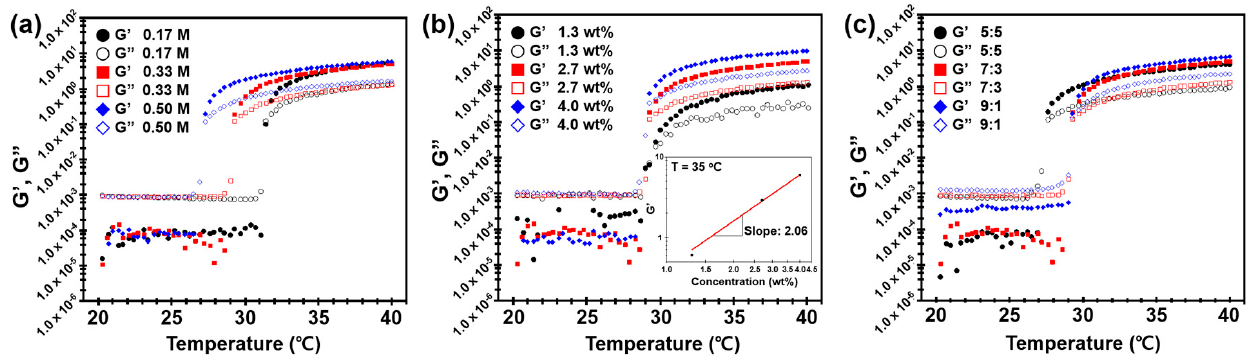
Figure 3. Evolution of storage (G’) and loss (G”) moduli of the p(NiPAm-co-HEMA) microgel dispersion from 20 °C to 40 ◦ C. The procedure was conducted under fixed stress of 0.05 Pa and a frequency of 0.1 Hz ( ω = 0.63 rad/s). ( a ) Change in dynamic modulus of the polymer at different salt concentrations. The concentration of polymer and molar ratio between NiPAm and HEMA were kept constant at 2.7 wt% and 7:3, respectively. ( b ) Change in dynamic modulus at different copolymer concentration ( c m ). The concentration of NaCl and molar ratio between NiPAm and HEMA were kept constant at 0.17 M and 7:3, respectively. Log plot between G’ and microgel concentration showed a power-law relationship with a slope of 2.06 (inset). ( c ) Change in dynamic modulus at different molar ratios between NiPAm and HEMA. The concentrations of polymer and NaCl were kept constant at 2.7 wt% and 0.33 M, respectively.